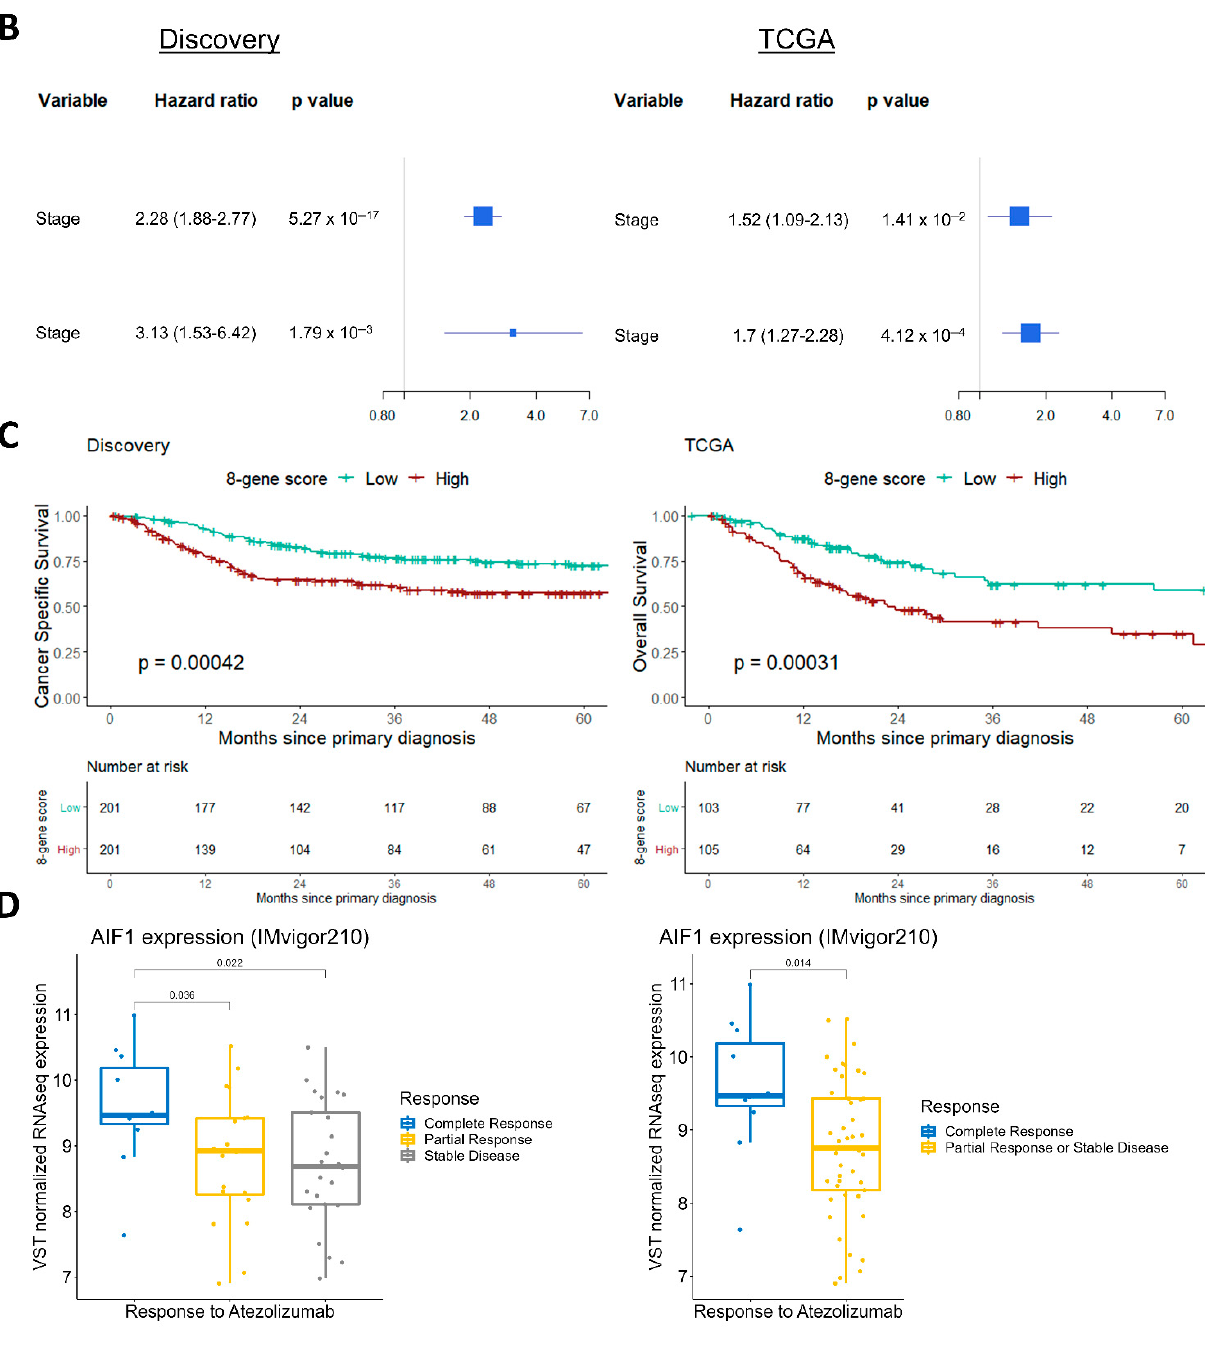
Figure 5. Validation of key findings in the TCGA-2017 and the IMvigor210 cohorts: ( A ) Forest plots showing hazard ratios (HRs) for the 8 monotonal genes with univariate prognostic value in both the discovery and TCGA validation datasets. ( B ) Multivariate analysis of stage and the 8-gene signature scores in the discovery and TCGA validation sets. ( C ) 5-year survival analysis between patients with high and low 8-gene signature scores, in the discovery and the TCGA data. ( D ) Data from the IMvigor210 trial illustrating AIF1 expression across responses to atezolizumab in immunotherapy